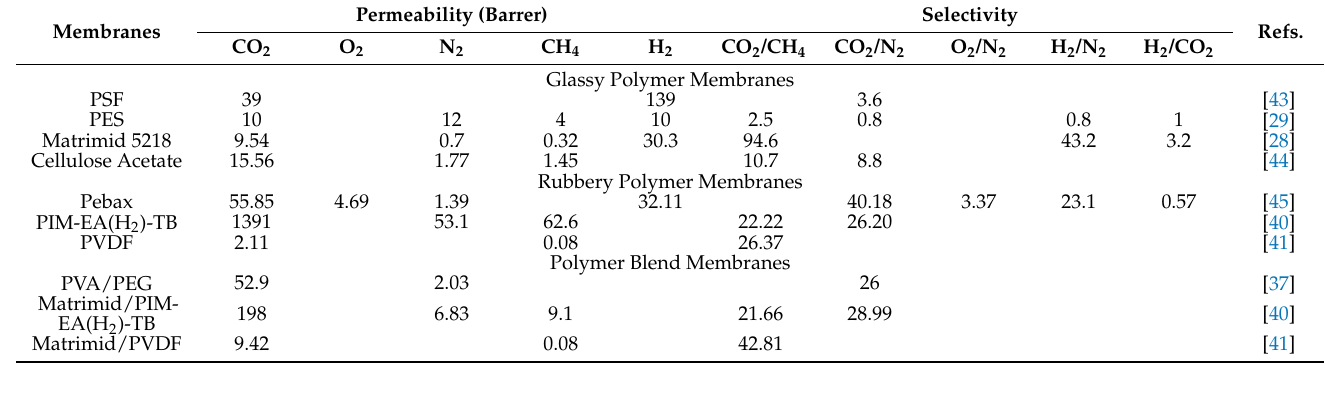
Table 3. Permeability and Selectivity of Polymer Membranes.